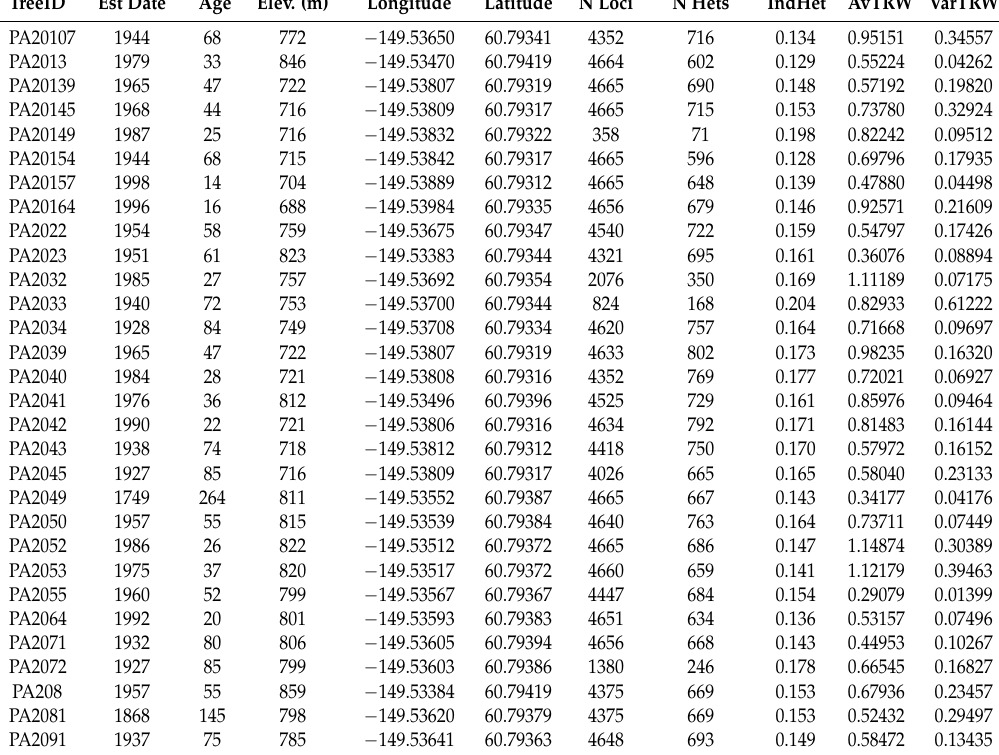
Table 1. Individual measurements for 30 trees sampled at the study site.